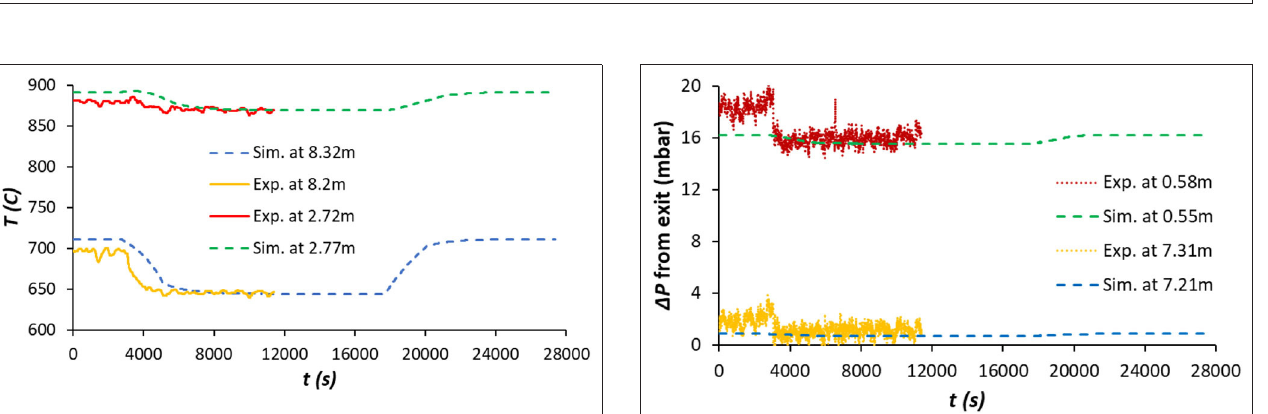
FIGURE 5 | Pressure profiles as predicted by the APROS and CFD simulations as well as the experiments for the three examined loads: (A) 100%, (B) 80%, and (C) 60%.